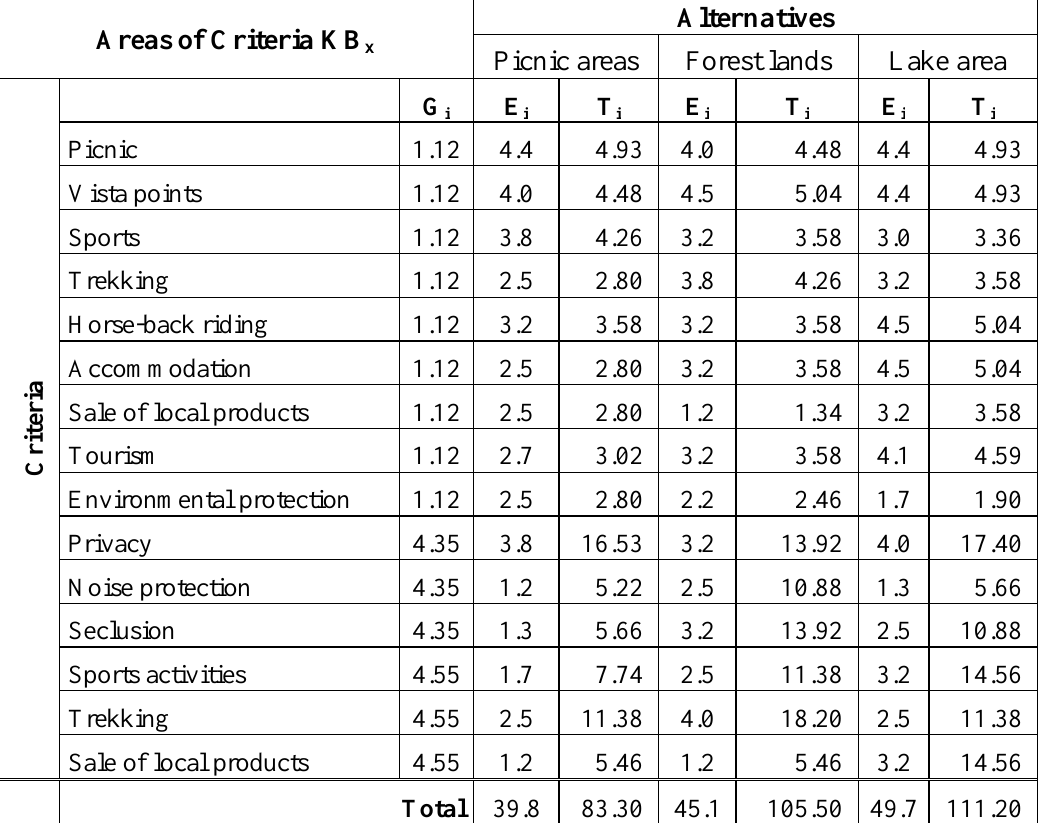
Table 6. Calculation scheme for VBA of open